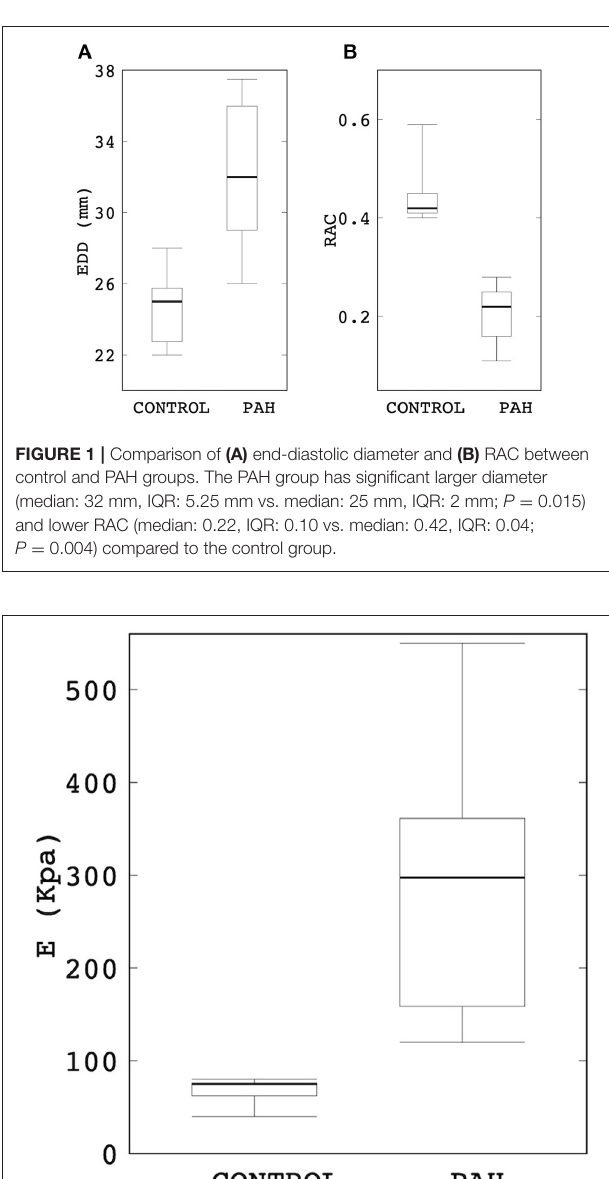
substantially smaller in the control group than the PAH group ( Figure 2